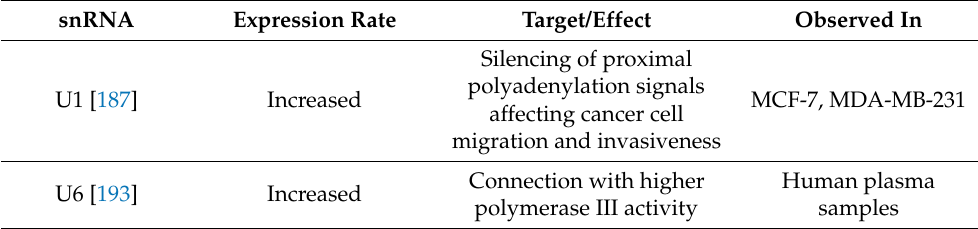
Table 4. list of snRNA action in